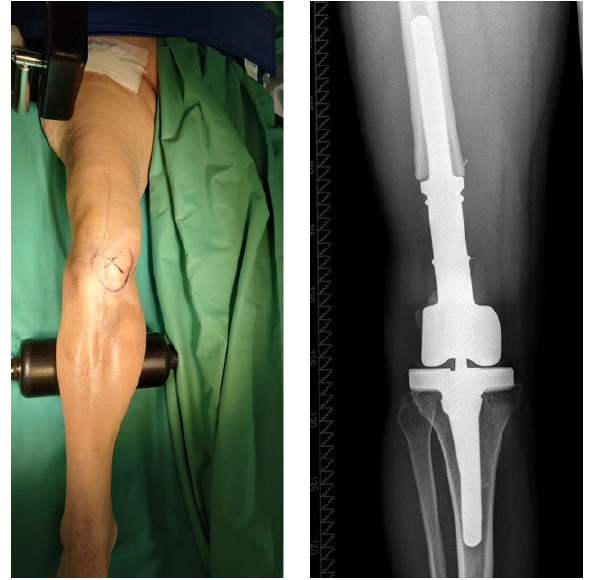
Figure 5. This patient was diagnosed with a chronic PJI of a megaprosthesis (“p 2 ”) with periarticular soft tissues in a good clinical condition (“T0”). The patient underwent two-stage revision surgery with successful reimplantation of a new megaprosthesis at second-stage surgery.